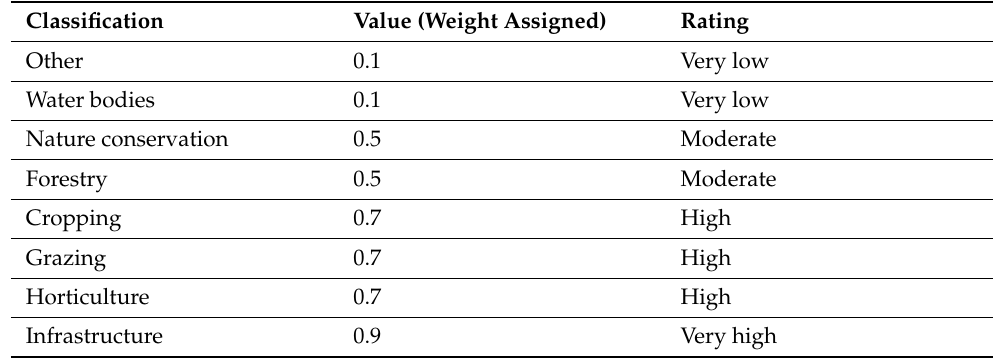
Table 1. Reclassified land use types, with respective values and ratings, for the land use type indicator. Classification Value (Weight Assigned) Rating